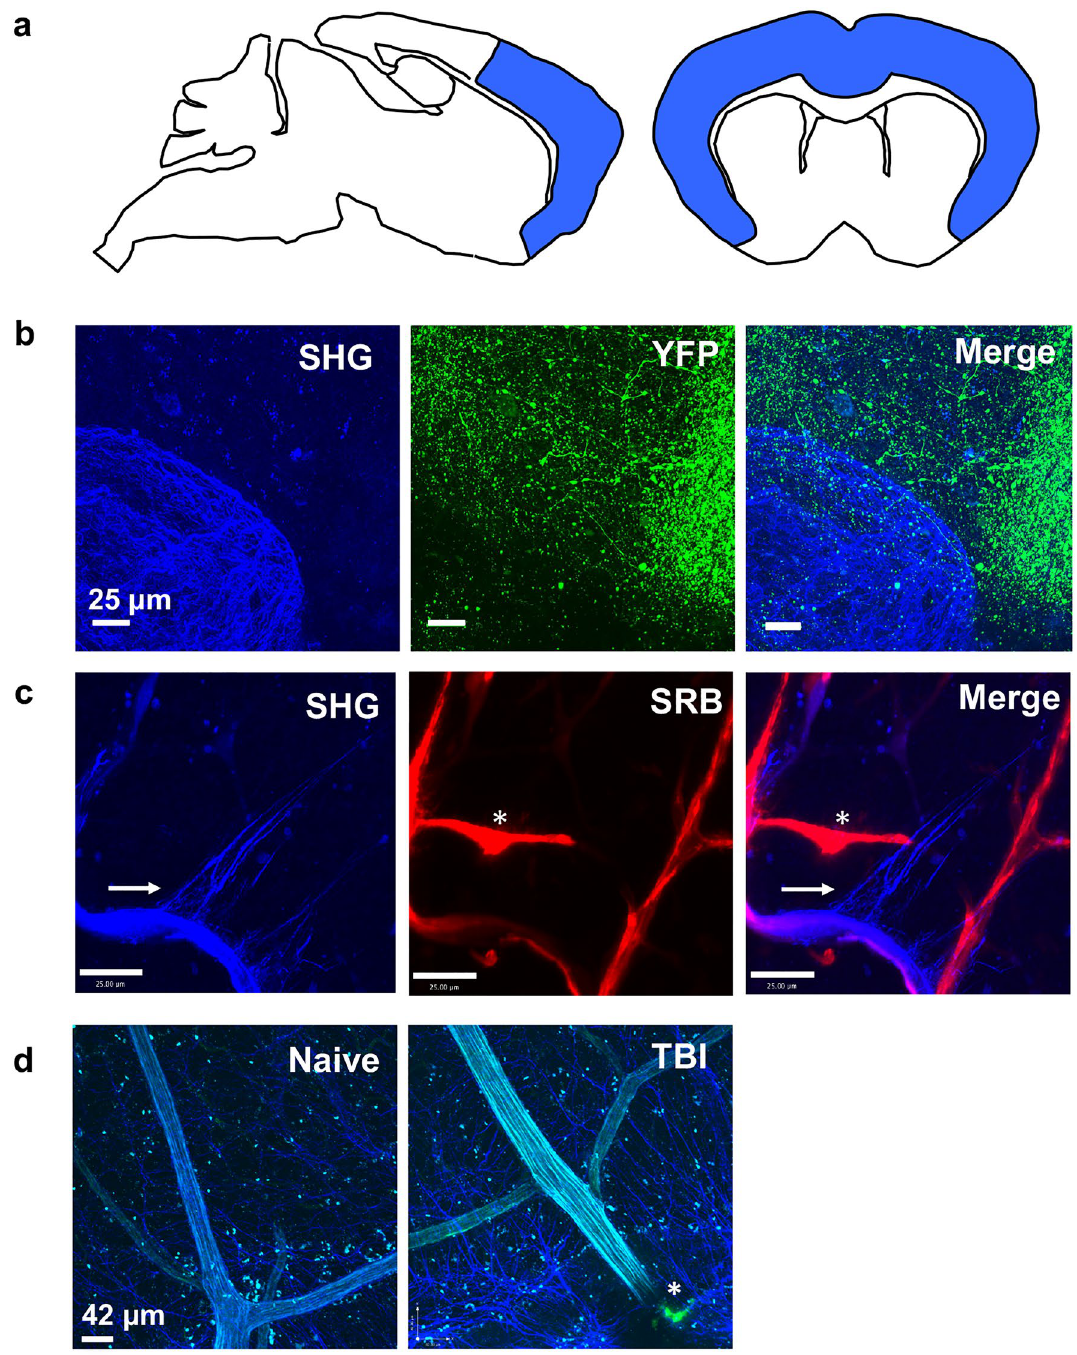
Figure 1. Parenchymal SHG signal is distinct from neurons and brain vasculature. ( a ) All imaging, multiphoton and confocal, focused on the frontal cortex of the mouse brain, highlighted in blue. ( b ) Thy1.1- YFP reporter mice were infected with Pru-OVA for 14 days before fresh (unfixed) brains were imaged using multiphoton microscopy to visualize fluorescent neurons (green) and SHG signal (blue). ( c ) Similarly, C57Bl/6 mice infected with Pru-OVA for 14 days were injected with the fluorescent dye SRB (red) i.v. 30 min prior to multiphoton imaging to distinguish the parenchymal SHG signal (blue) from that generated by collagen rich blood vessels. ( d ) SHG signal (blue) in naïve mice and following traumatic brain injury. Green fluorescence (*) indicates vascular leakage of FITC Dextran at injury site. For all panels, 30 μm z-stacks were collected in areas of the frontal cortex from fresh tissue explants. Images are representative of at least 2 individual experiments where n = 3